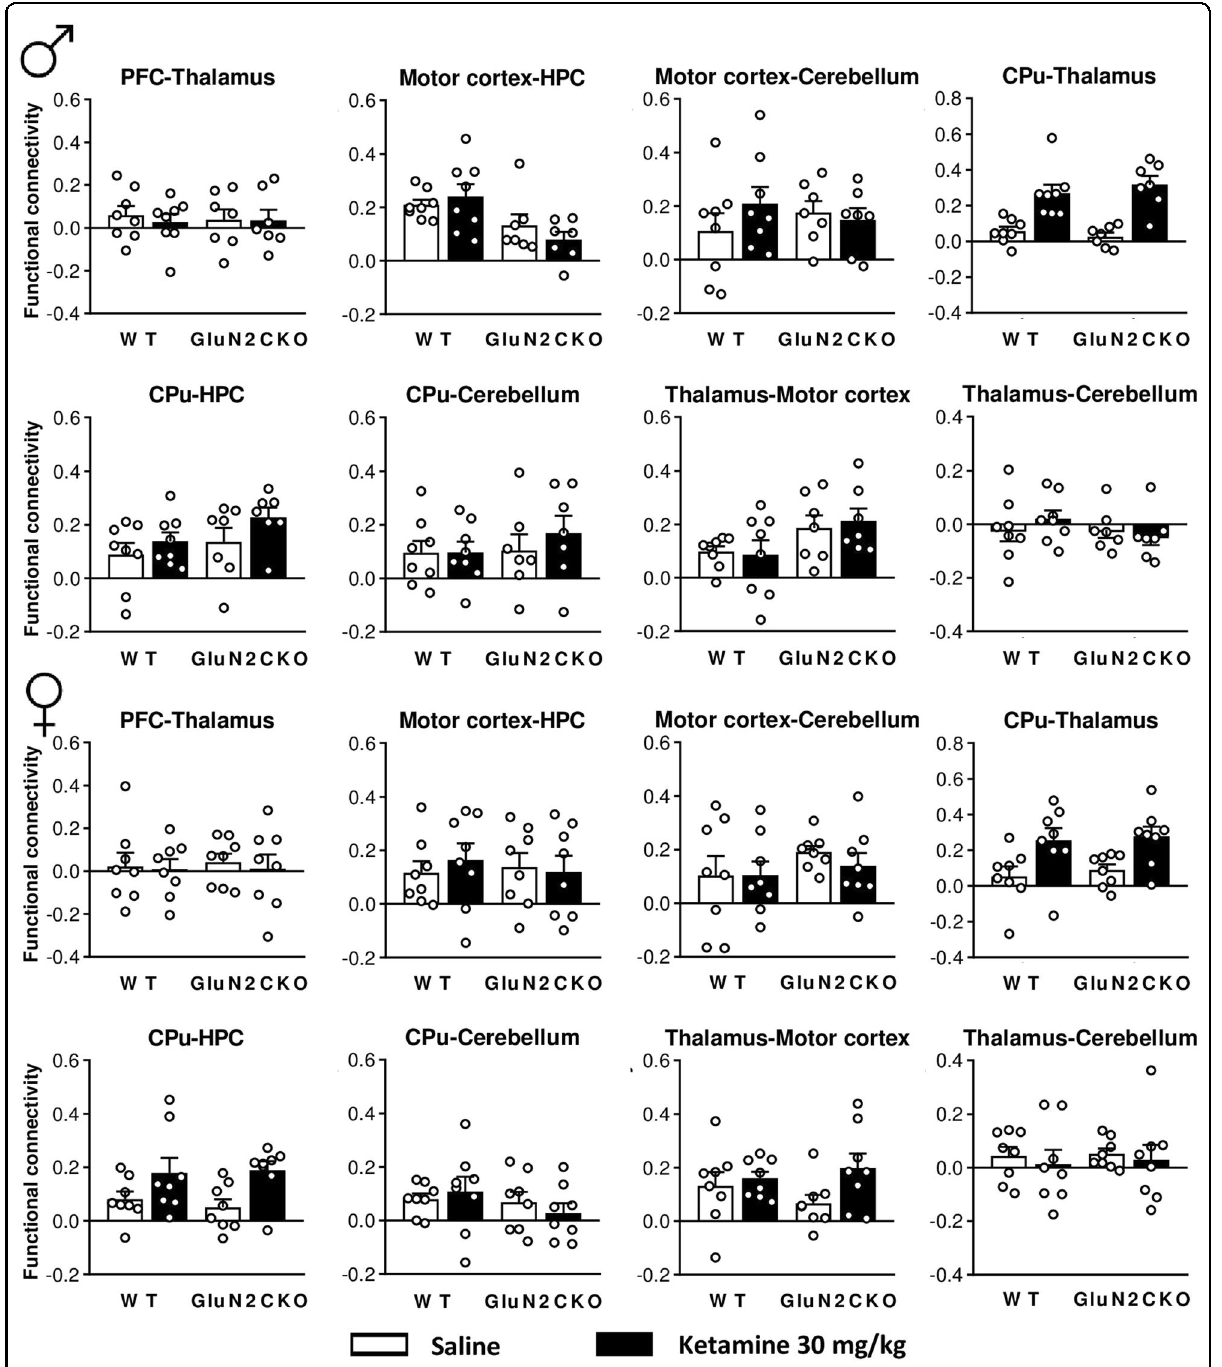
Fig. 5 fMRI study in WT and GluN2CKO mice of both genders. Functional connectivity for male ( ♂ ) and female ( ♀ ) WT and GluN2CKO mice ( n = 8 for male WT groups and for female WT and GluN2CKO groups; n = 7 for male GluN2CKO groups). Prefrontal cortex (PFC), hippocampus (HPC), and caudate – putamen nuclei